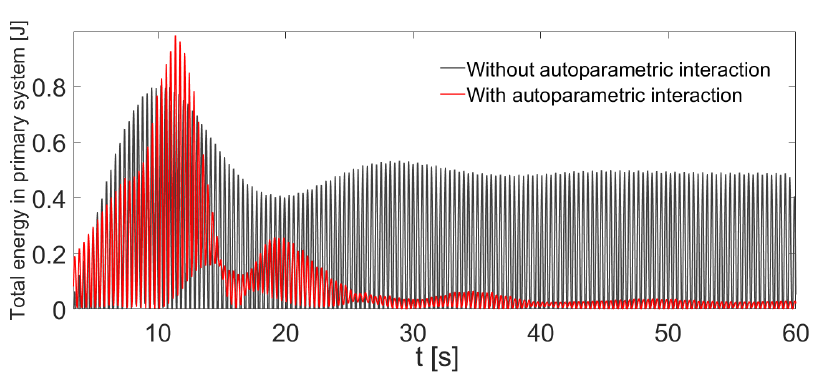
Figure 14. Graph of the total energy in the main system with and without nonlinear pendulum absorber.